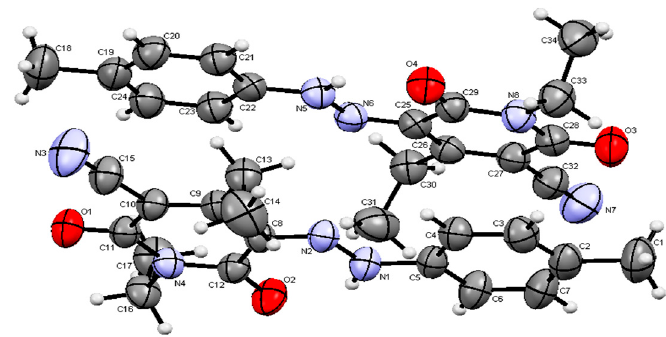
Figure 3. ORTEP of dye 18b.